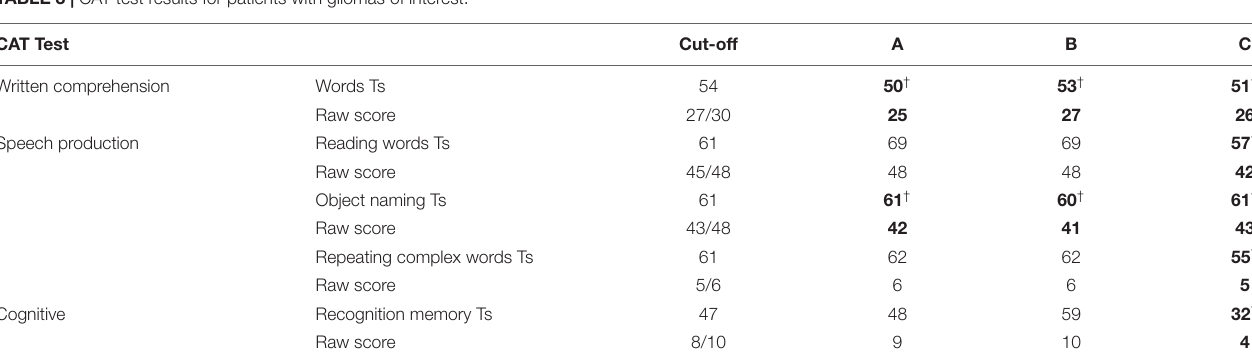
The table lists the statistical criteria used to identify regions of abnormal activation in the glioma patients of interest (GOI) compared to the neurotypical control participants (NC) for auditory semantic matching > rest/visual semantic matching; and object naming > rest/visual semantic matching. Group effects (contrasts 1-2) were assessed at a statistical threshold of p < 0.05 with family wise error correction across the whole brain (p < 0.05c) and individual patient effect (contrasts 3–5) were assessed, within these regions, at an uncorrected threshold of p < 0.05 (p < 0.05u). Results are reported for contrast (2) to (5) in Tables 5A,B . TABLE 3 | CAT test results for patients with gliomas of interest.